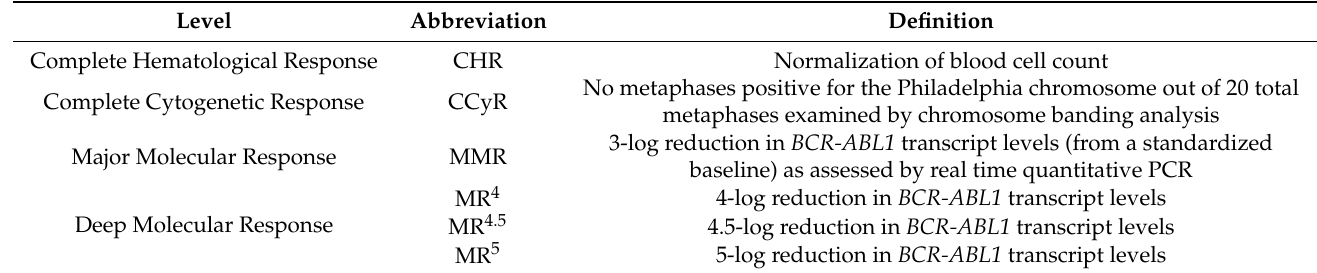
Table 1. Milestones in CML response to